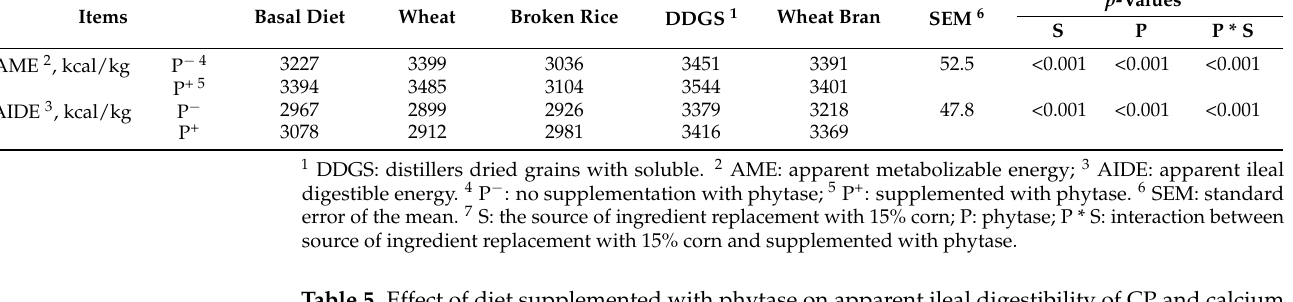
Table 5. Effect of diet supplemented with phytase on apparent ileal digestibility of CP and calcium and phosphorus in broilers.